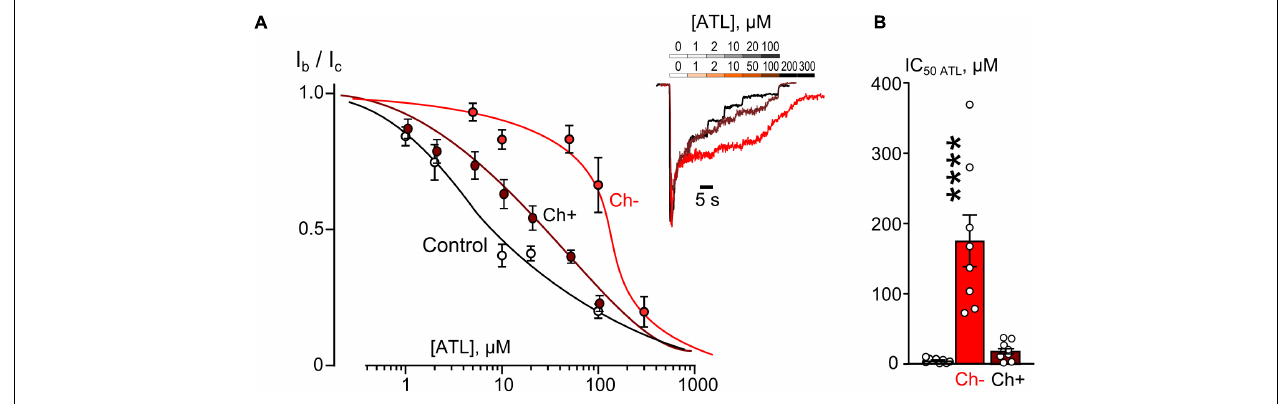
FIGURE 4 | Plasma membrane cholesterol extraction by M β CD affects inhibition of NMDAR currents by amitriptyline (ATL). (A) Concentration-inhibition curves for ATL effect on currents activated by 100 µ M NMDA + 30 µ M Gly obtained in 2 mM [Ca 2 + ] in control, after cholesterol extraction with M β CD (Ch − ), and after cholesterol repletion with water soluble cholesterol (Ch+). Symbols show mean values ± SEM of the relative amplitudes of currents (I b /I c ) in the presence (I b ) and absence (I c ) of different ATL concentrations. In insert sample traces of NMDAR currents normalized to the steady-state amplitude without ATL, recorded at –70 mV in the presence of increasing ATL concentrations in control (upper row) and after cholesterol extraction or repletion (lower row). (B) Mean IC 50 s for ATL inhibition of NMDAR currents in control, cholesterol depleted (Ch − ) and cholesterol repleted (Ch+) neurons derived from data on (A) . Data obtained in cholesterol depleted cells differ significantly from these of control and cholesterol repleted neurons (**** p = 0.00004), one-way ANOVA with post hoc Tukey’s test. Mean IC 50 values are